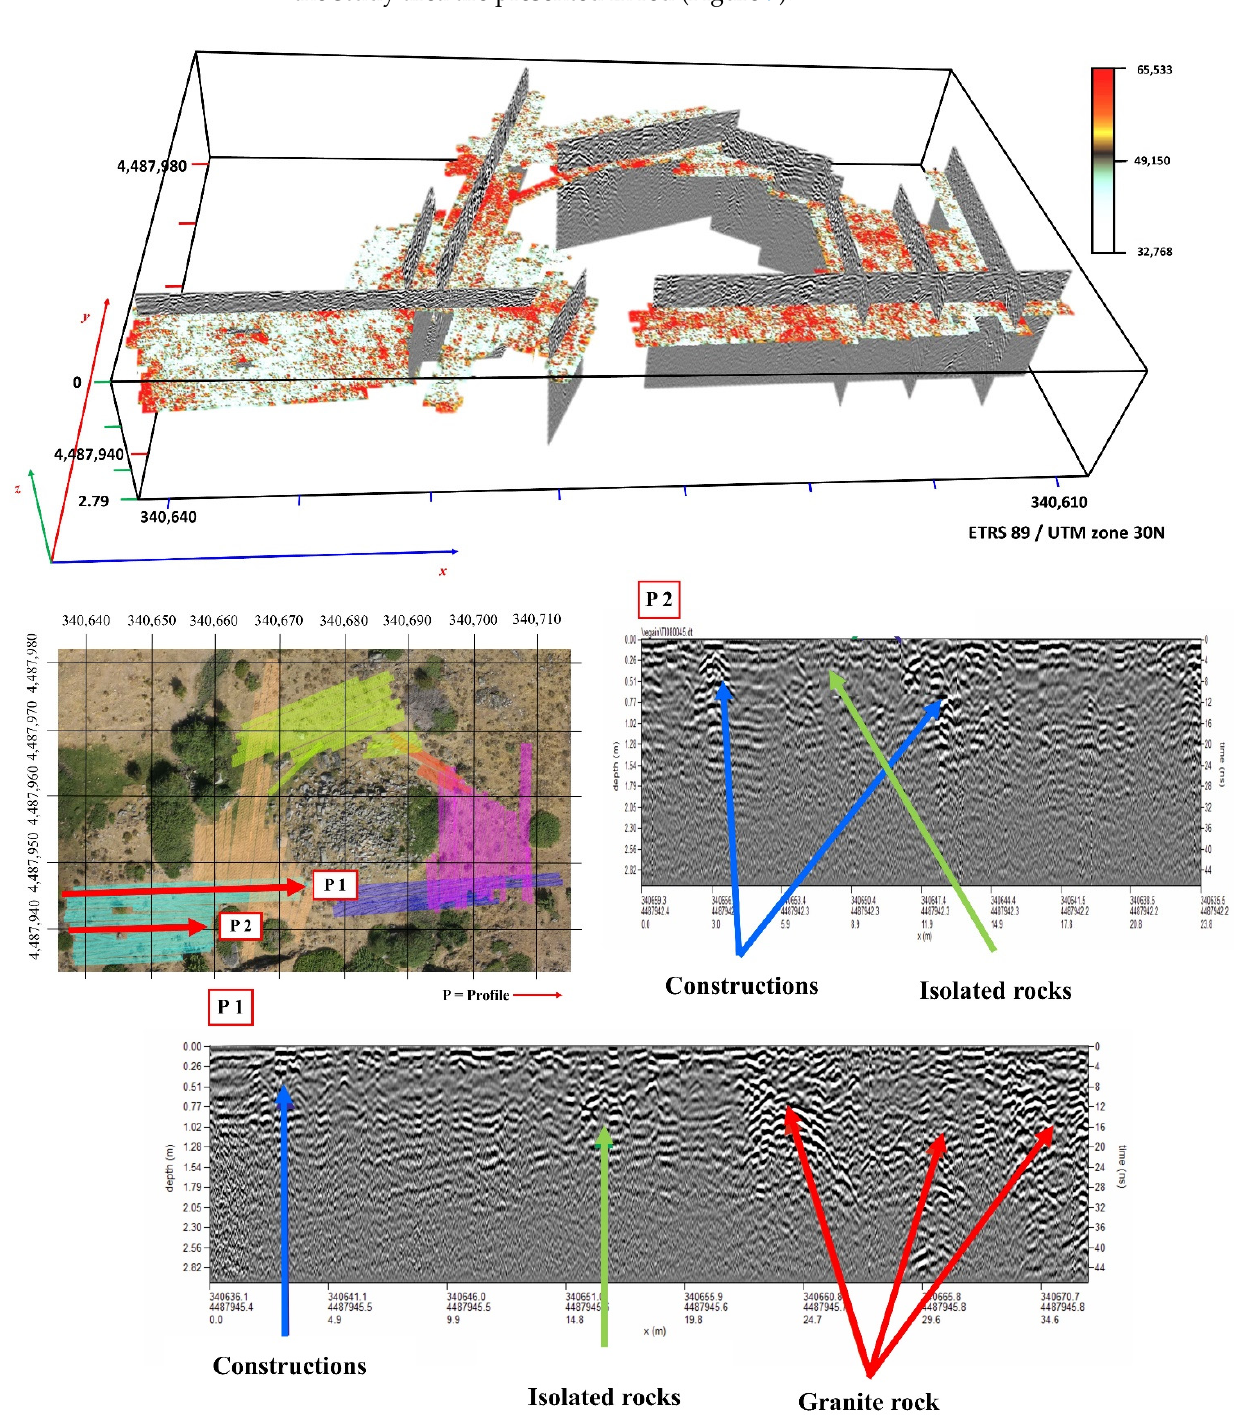
Figure 9. GPR 3D blocks with horizontal slices and vertical sections. Radargrams with interpretations of the anomalies. Through the different radargrams, diverse reflection typologies can be observed (Fig- ure 9). Hyperbola groupings with great signal amplitude are detected. These present alignments both vertically and horizontally and have consequently been interpreted as areas of contact between the granite rock, the soil, and its internal structures, such as joints or fractures with some moisture content. In the SW area from “El Torreón”, hyperbolic-type anomalies with a lower signal amplitude and wall typologies have been detected. The horizontal sections present certain alignments confirming that they are most probably walls. Occasionally, at these depths